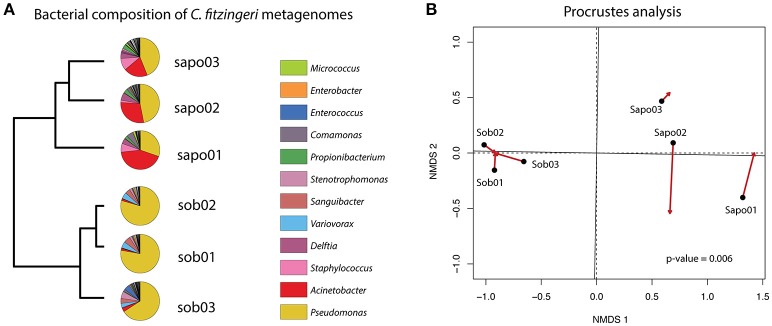
(A) Pie charts of the most abundant genera obtained with metaphlan for each frog microbiome sample. An UPGMA on the left shows grouping of similar samples based on the relative abundance of bacterial taxa. (B) Procrustes analysis comparing the relative abundance of bacterial taxa (Bray-Curtis dissimilarity matrices) of the 16S rRNA gene amplicon data (arrowheads) and the shotgun metagenome data (black circles). A p-value of 0.006 (PROTEST test) indicates that the matrices are more similar than expected by random association.